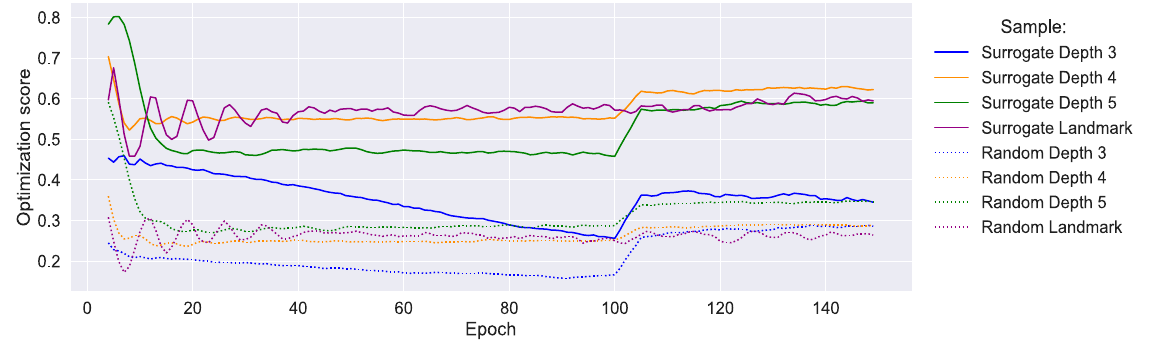
Figure 14. Boxplots for the time in seconds (smaller is better), required to find the first optimal Figure 15. Mean optimization score for different decision models. The full line represents the alternative for different benchmark models. average optimization score of the alternatives generated by the surrogate model. The dashed line represents the average optimization score of the random alternatives.